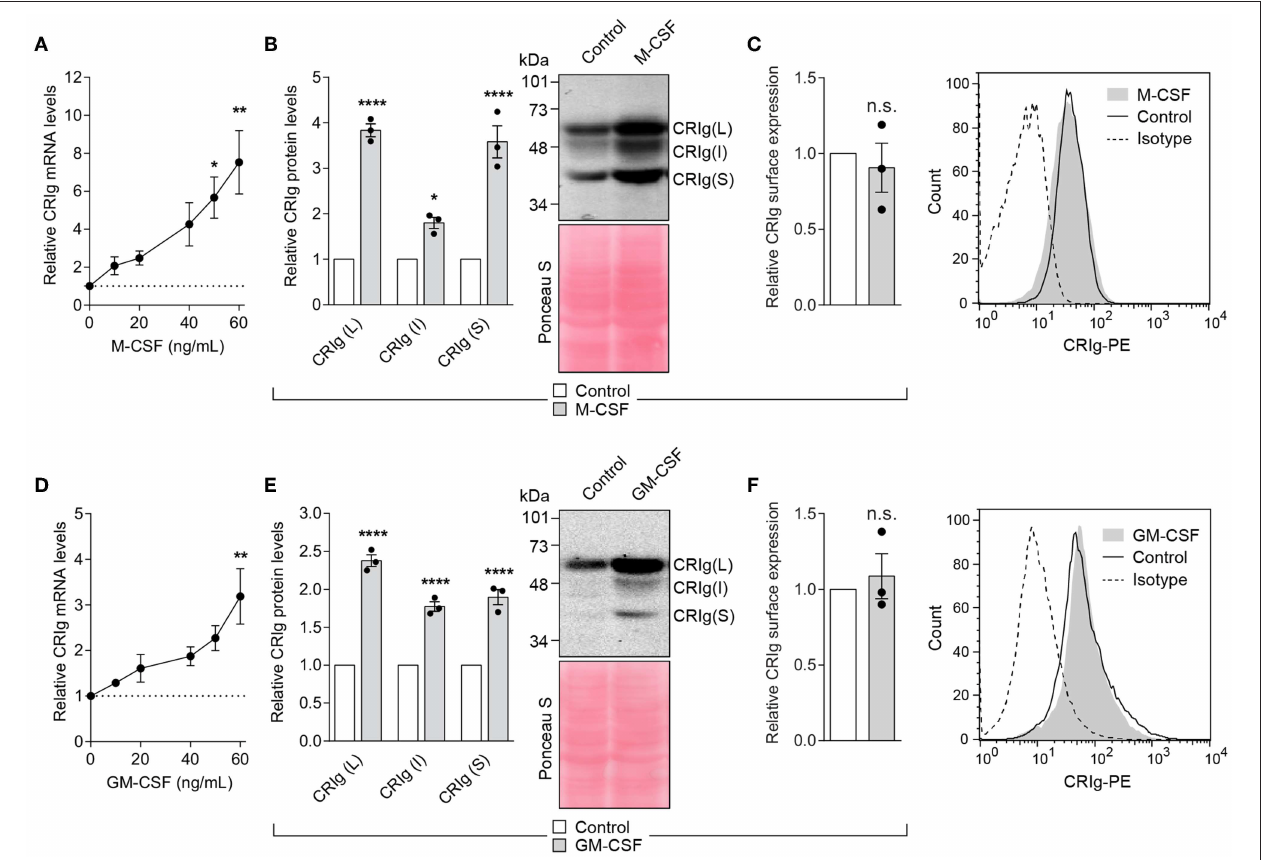
FIGURE 7 | M-CSF and GM-CSF increase CRIg in DC. (A,D) DC were treated with varying concentrations of the CSF and the CRIg mRNA expression determined. Changes in CRIg isoform proteins (B,E) and cell surface (C,F) CRIg expression on DC treated with 40ng/ml of each CSF are shown. Data are presented as means ± SEM of three experiments, each conducted with cells from different individuals. Significance levels are indicated by asterisks: * P < 0.05, ** P < 0.01, **** P < 0.0001, whilst n.s. indicates